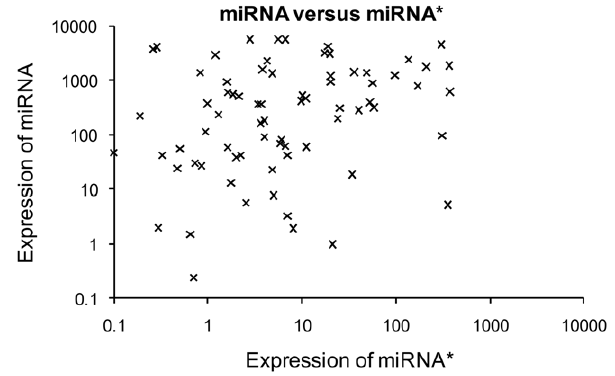
Figure 3. The expression of miRNA and paired miRNA*. A collection of miRNAs and paired miRNA antisense sequences (miRNA*s) were determined to be expressed in nine bladder urothelial carcinoma patients by deep sequencing. We identified a remarkable divergence of expression between miRNA and paired miRNA*. The expression of miRNA/miRNA* pairs is shown in scatter plot with logarithm coordinate system; each point represents the expression of a miRNA/miRNA* pair. In most miRNA/miRNA* pairs, the expression level of miRNA was higher than that of paired miRNA*. In a small number of miRNA/miRNA* pairs, miRNA was less abundant than paired miRNA*.